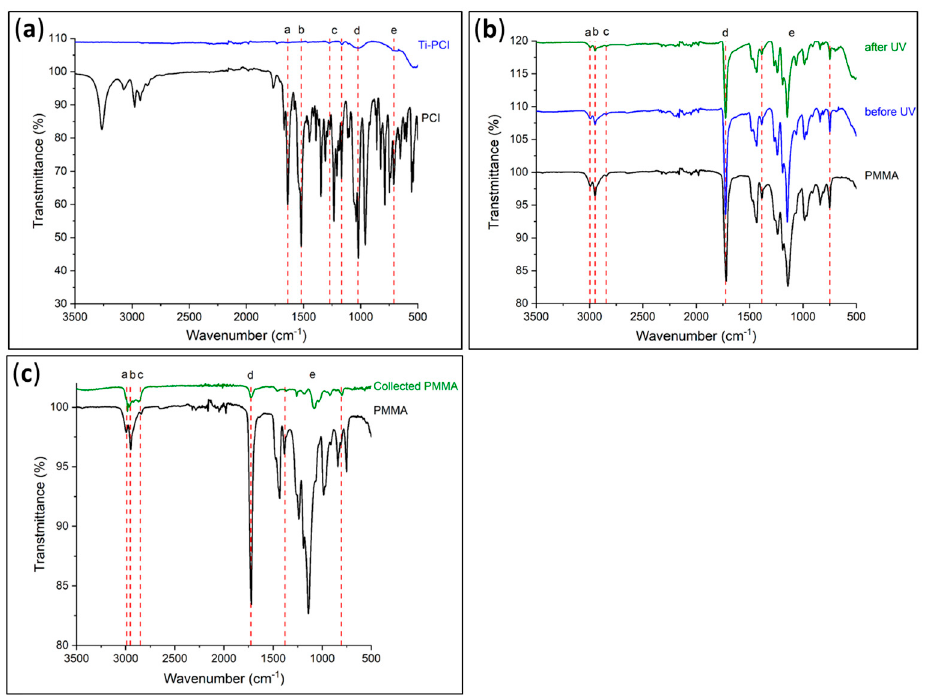
Figure 8. Infrared spectra of ( a ) initiator-modified (Ti–PCI) and ( b ) PMMA-modified (Ti–PMMA) Ti plates before and after exposure to UV radiation, as well as ( c ) collected PMMA under UV radiation.